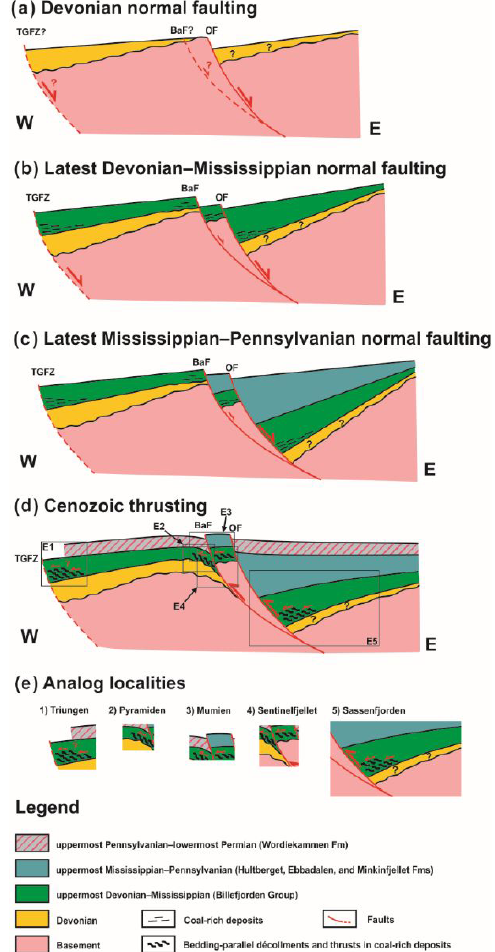
Figure 6. Schematic cross sections showing the possible evolu- tion of the Billejorden Fault Zone and its relationship with de- formation within the Billefjorden Group in Devonian–early Ceno- zoic times. (a) Relatively high pre-Devonian basement rocks in the east and a collapse basin in the west with erosion-related ex- humation of basement rocks in the footwall of the Odellfjellet Fault. (b) Widespread latest Devonian–Mississippian normal fault- ing and localization of thick coal deposits on basin edges. (c) Lat- est Mississippian–Pennsylvanian normal faulting localized along the Billefjorden Fault Zone (Balliolbreen and Odellfjellet faults). (d) Inversion of Devonian–Carboniferous normal faults and basins during early Cenozoic Eurekan deformation, including top-west thrusting of Proterozoic basement onto Lower Devonian to low- ermost Upper Devonian rocks of the Andrée Land Group and Mimerdalen Subgroup along the Balliolbreen Fault, the forma- tion of bedding-parallel décollements and thrusts in uppermost Devonian–Mississippian coal-rich deposits, and intense internal de- formation of Lower Devonian to lowermost Upper Devonian sedi- mentary rocks (not detailed here) that acted as a buttress. (e) Parts of the cross section in (d) that fit field observations (from the present contribution and by previous workers) in key localities discussed in the text (Fig. 1a–b). The location of the schematics in (e) is shown as black frames in (d) . Abbreviations – BaF: Balliolbreen Fault; OF: Odellfjellet Fault; TGFZ: Triungen–Grønhorgdalen Fault